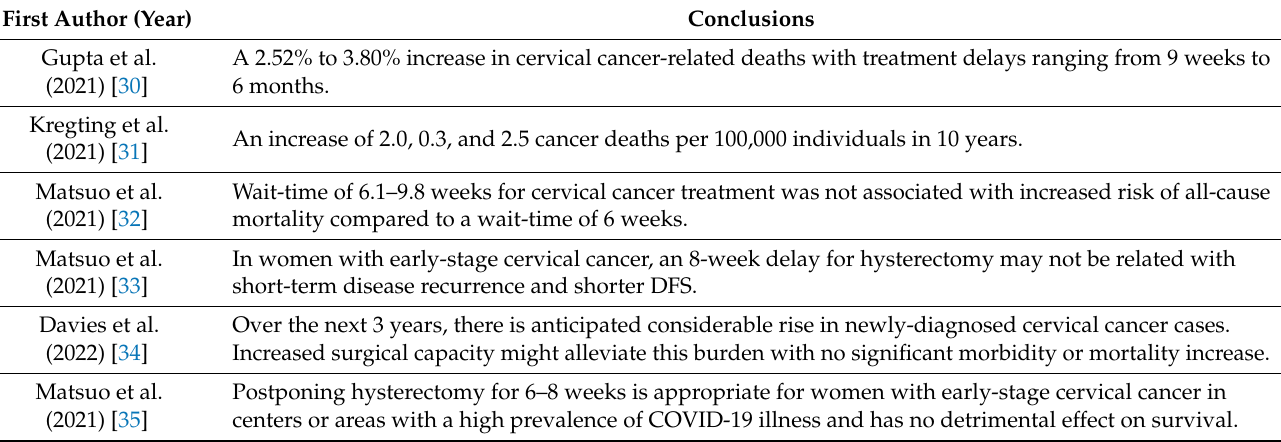
Table 4. Existing studies describing the COVID-19 pandemic impact on cervical cancer